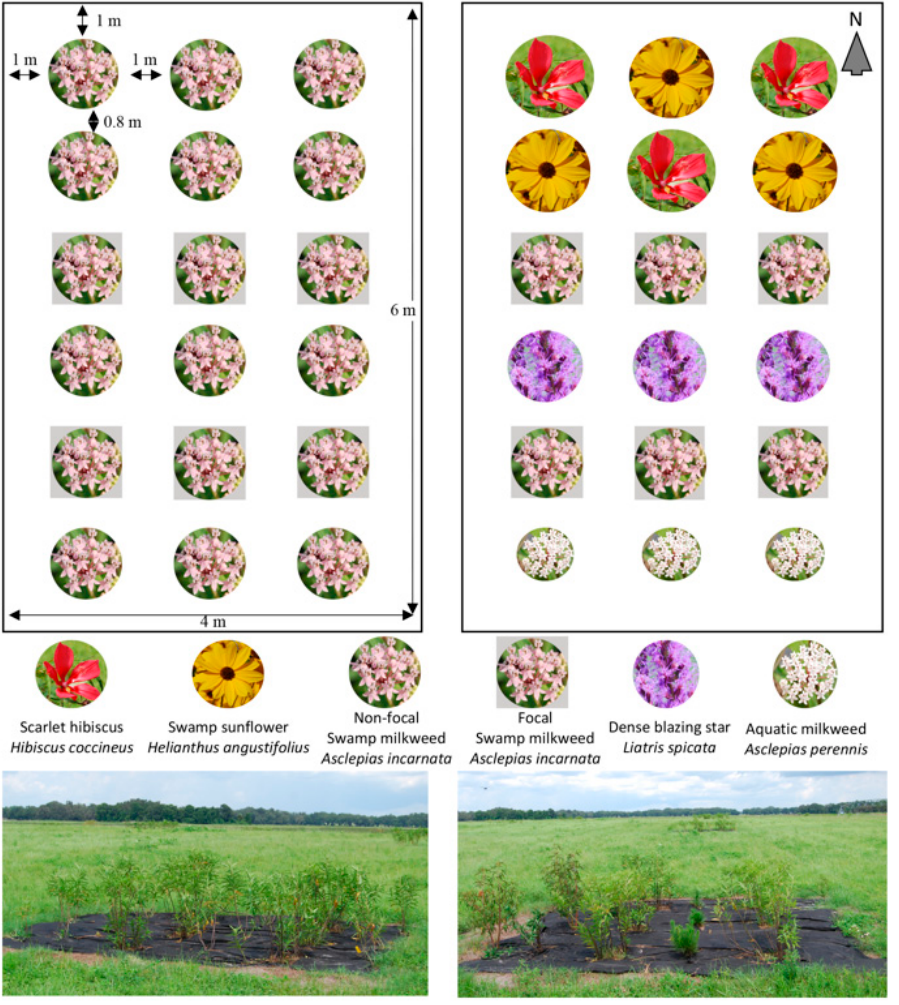
Figure 1. Depiction of milkweed monoculture ( left ) and mixed-species ( right ) experimental field plot design and composition. The top of the plots is oriented north. Photographs below each plot diagram demonstrate plot appearance in early summer of 2019.